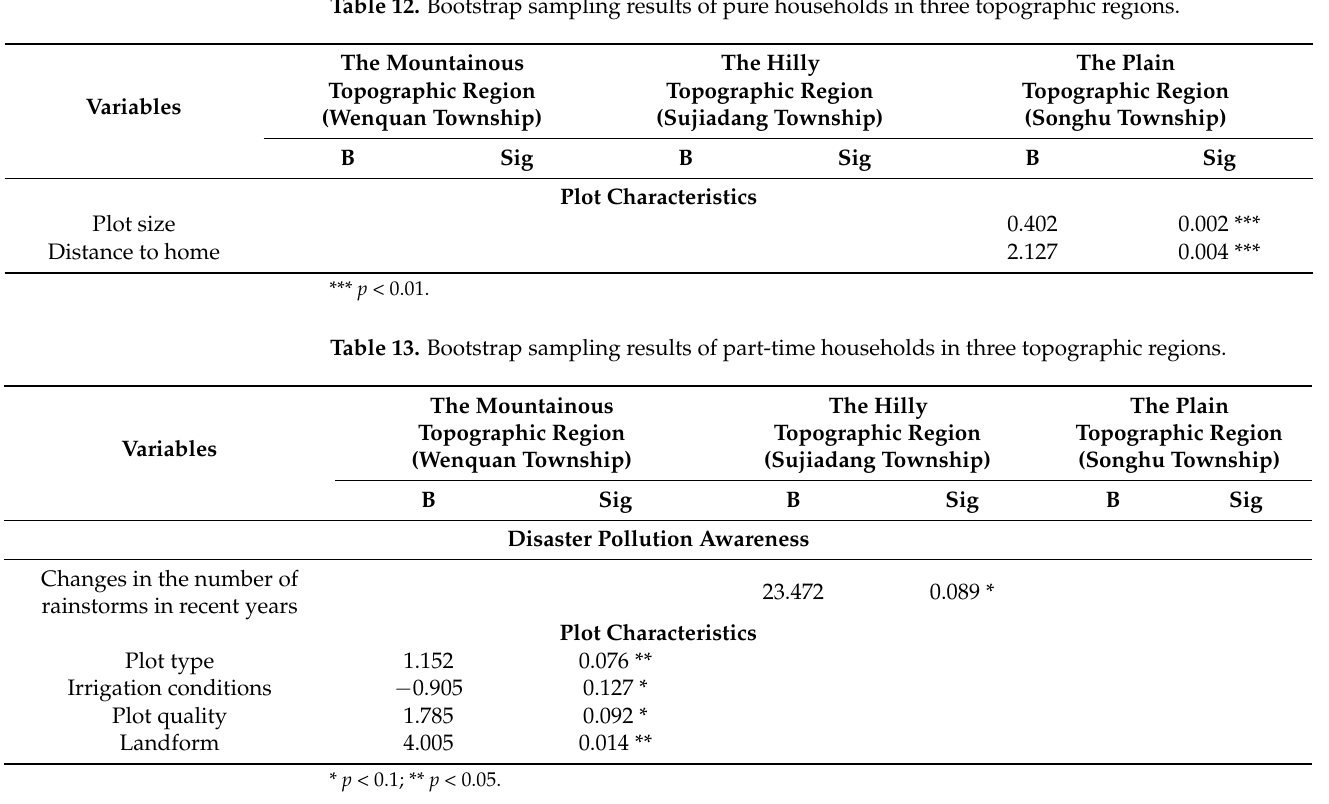
Table 12. Bootstrap sampling results of pure households in three topographic regions.